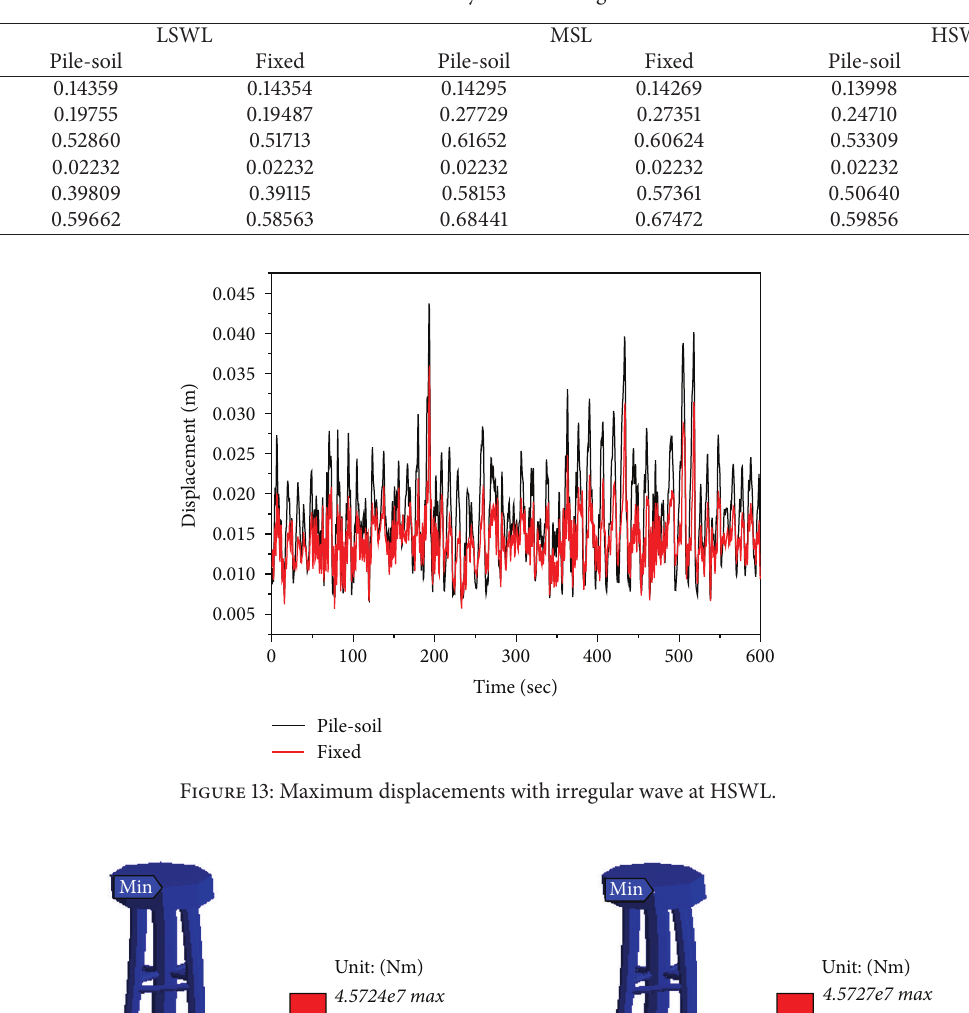
Table 15: Member unity checks for regular wave.